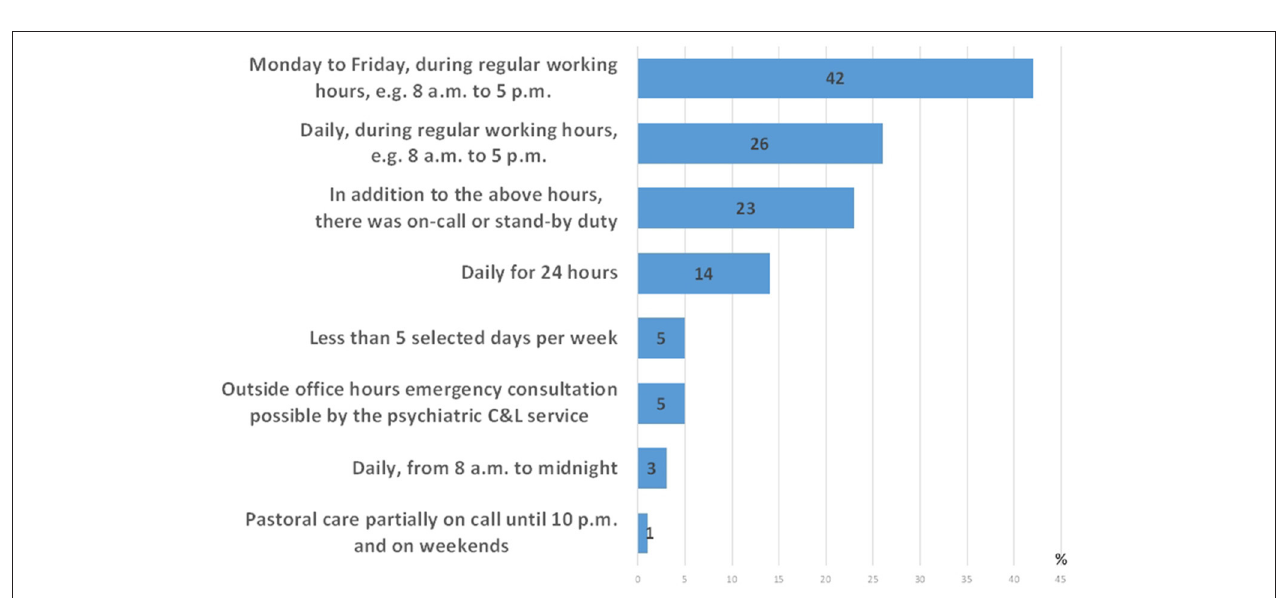
FIGURE 5 | Maximum availability of psychosocial care for COVID-19 patients in terms of time (multiple answers possible).